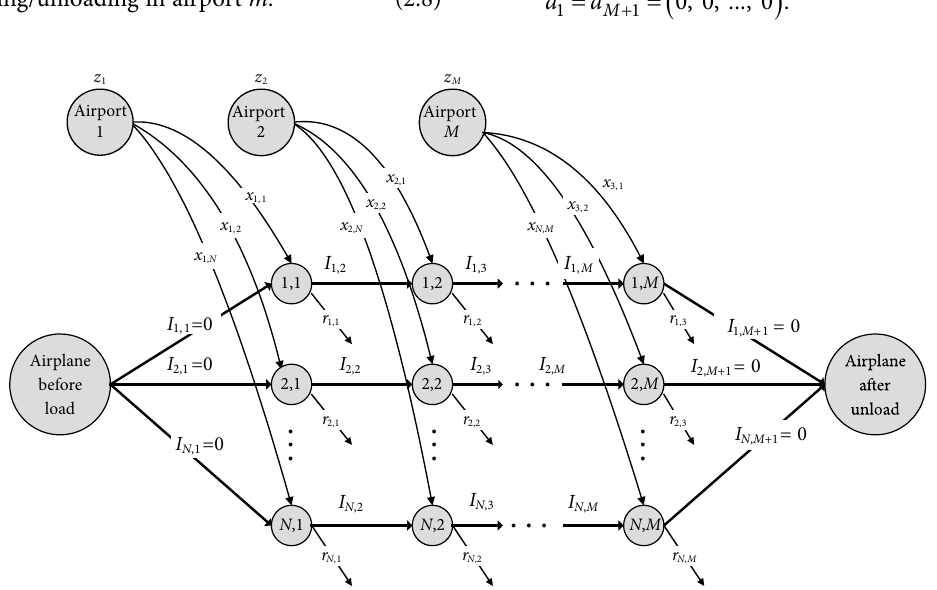
Fig. 5. Transportation problem can be represented by a flow diagram of oriented acyclic